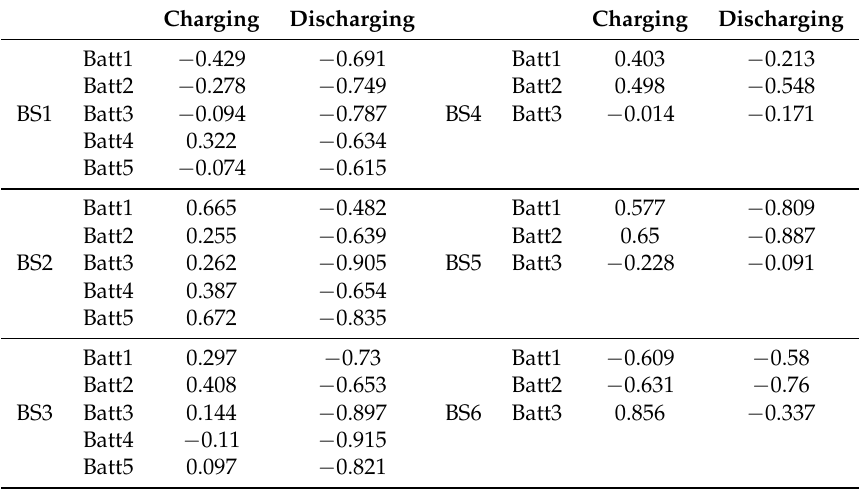
Figure 5. The maximum measured values on the given battery set at the given time. The temperature data are visualized on the left side and the voltage data on the right side. Table 2. Correlation coefficients between pairs of variables (thermal range and voltage range) of all battery sets during both processes (charging and